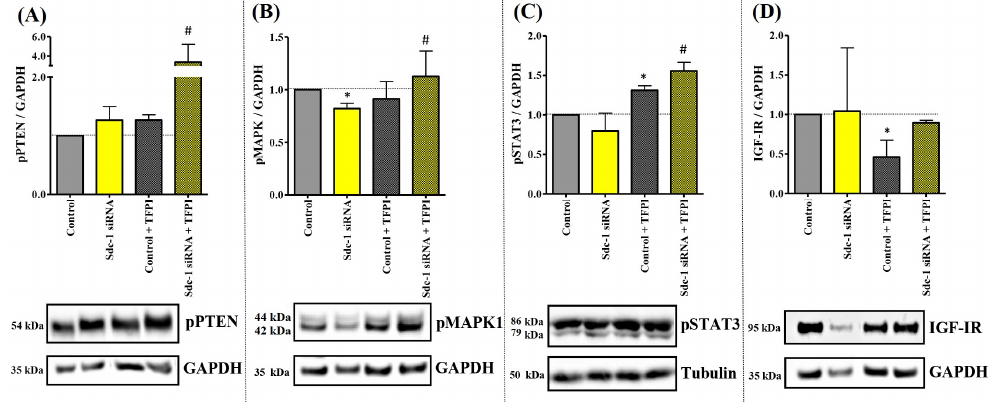
Figure 2. Sdc-1-depletion in MDA-MB-231 is associated with a differential kinase activation profile of different downstream protein targets of TF signaling. Phosphorylated forms of ( A ) PTEN (Ser380), ( B ) p44/42 MAPK (Erk1/2) (Thr202/Tyr204), and ( C ) STAT3 (Tyr705), as well as ( D ) the expression of IGF-1R, were analyzed after Sdc-1-KD and 48 h of 50 µg/mL TFPI treatment by means of Western blotting. Data were normalized to GAPDH levels (n = 3). Representative bands and quantitative analysis via densitometric scanning are shown. Data represent the mean ± SEM. Asterisks on the top of the bars indicate significant differences between controls and all the conditions. The line sover the bars indicate a significant difference (# p < 0.08, * p < 0.05).